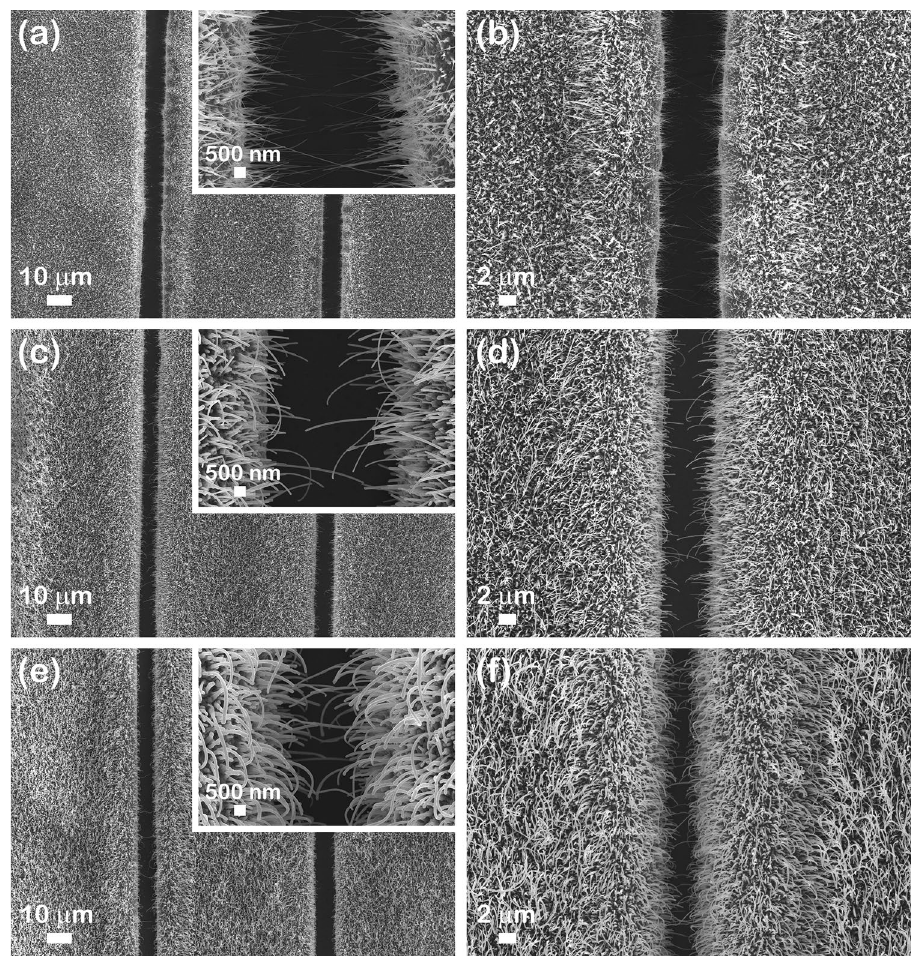
Figure 3. FESEM images at different magnifications of: ( a , b ) Inset CuO_MIE, ( c , d ) Inset CuO–ZnO_MIE_1 and ( e , f ) Inset CuO–ZnO_MIE_2.